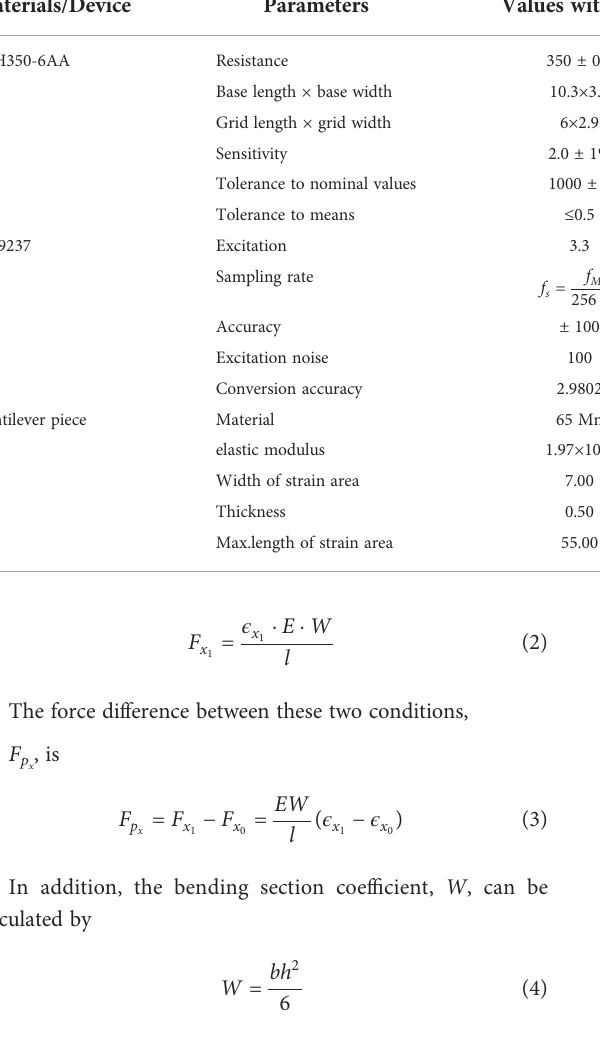
TABLE 1 The key speci fi cations of BFH350-6AA and NI 9237.